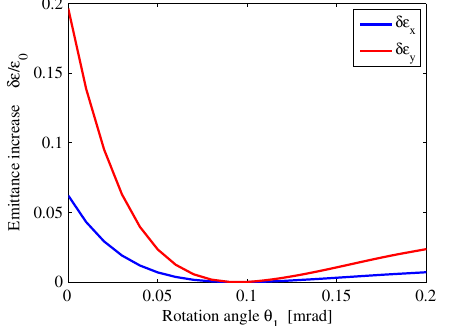
FIG. 20. Emittance increase versus the rotation angle θ 1 ( θ 2 ¼ 0 ) for a 2-meter-long section with beam offset Δ ¼ 40 μ